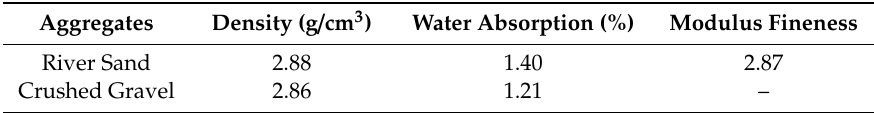
Table 2. Properties of fine and coarse